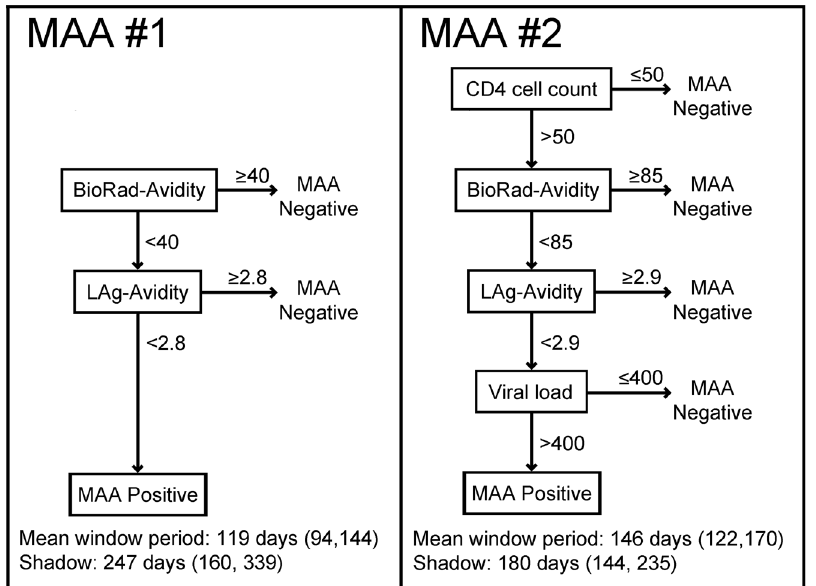
Figure 2. Optimized multi-assay algorithms (MAAs). The figure shows two optimized MAAs that include the LAg-Avidity assay. The assays, assay cutoffs, window periods, and shadows are shown for each MAA. The 95% confidence intervals for the window periods and shadows are